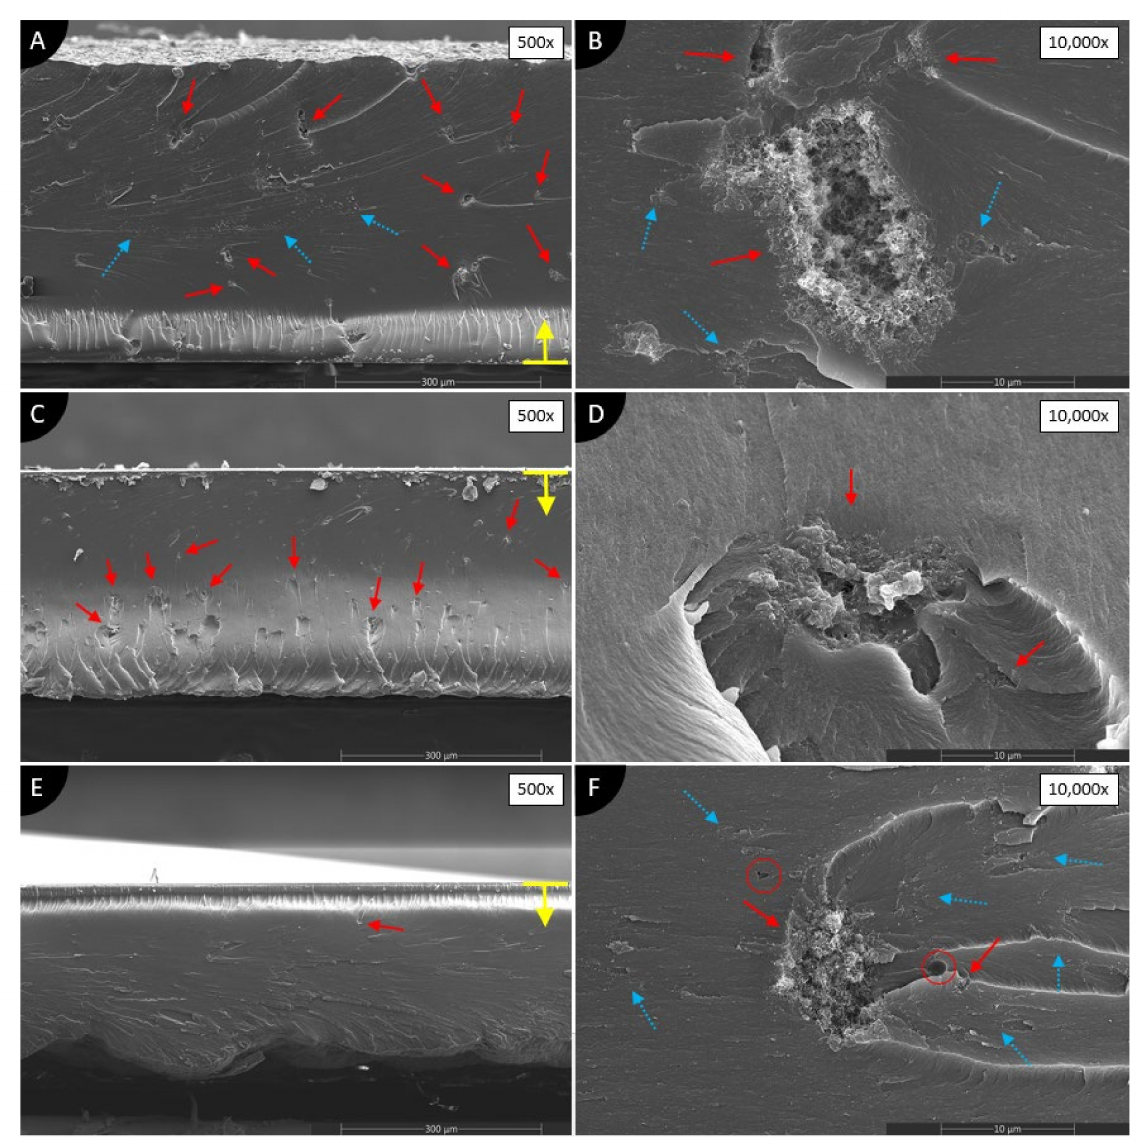
Figure 6. SEM images of cross-sections of 0.1 wt.% MWCNTs/photopolymer composites dispersed in ( A , B ) acetone; ( C , D ) isopropanol; ( E , F ) ethanol. Red, solid line arrows show agglomerations. Blue, dotted arrows show clusters of average dispersion. Red circles define voids. A yellow arrow with a line defines the direction of UV light and the surface of the composite on the glass during